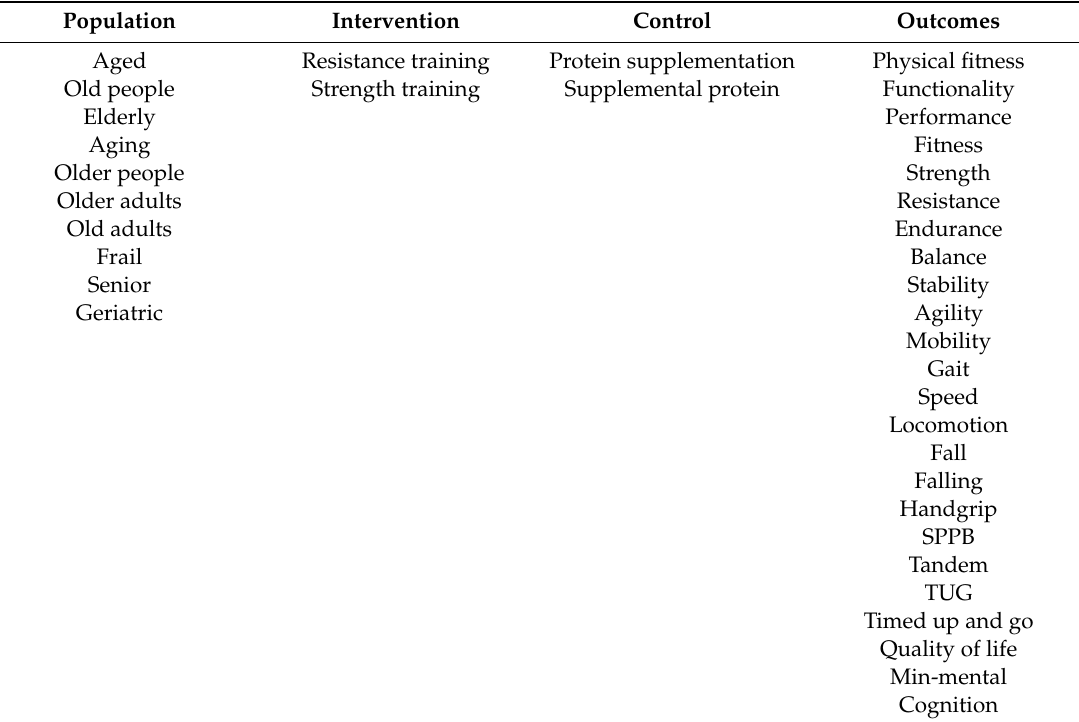
Table 1. Keywords used for the search strategy.